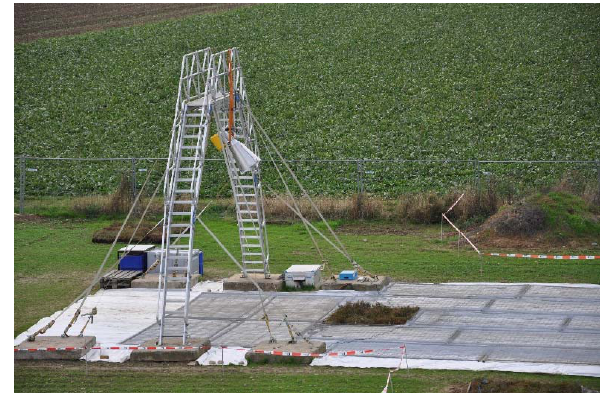
Figure 2. Undisturbed soil–vegetation blocks excavated using a hydraulic excavator from the HOBE heathland test site in the Skjern River catchment, Denmark ( left ), and transported in wooden boxes ( right ) to the Selhausen remote sensing field laboratory in Germany .